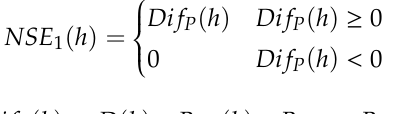
Figure 5. Pareto optimization for DER combinations for each analyzed MG.